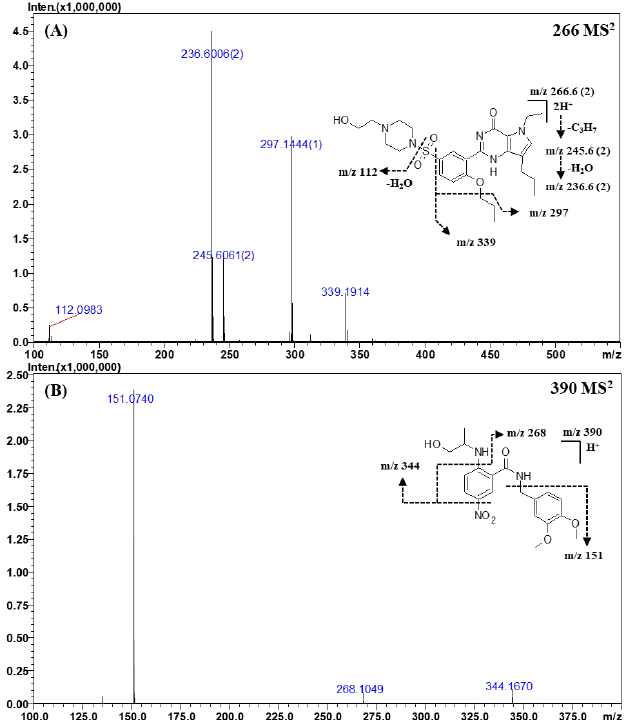
Figure 4. Representative MS n ( n = 2, 3) spectra and proposed fragmentation mechanisms of mirodenafil ( A ) and xanthoanthrafil ( B ). The bracketed numbers next to the m / z values indicate the charge state of the ions. Molecules 2020 , 25 , x FOR PEER REVIEW